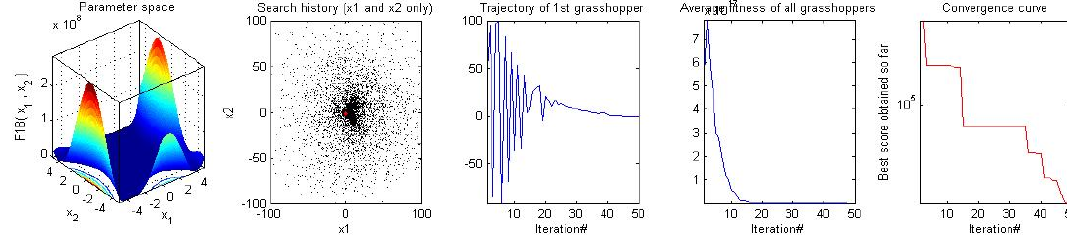
Figure 19. HAGOA behavior on multimodal function (F18)